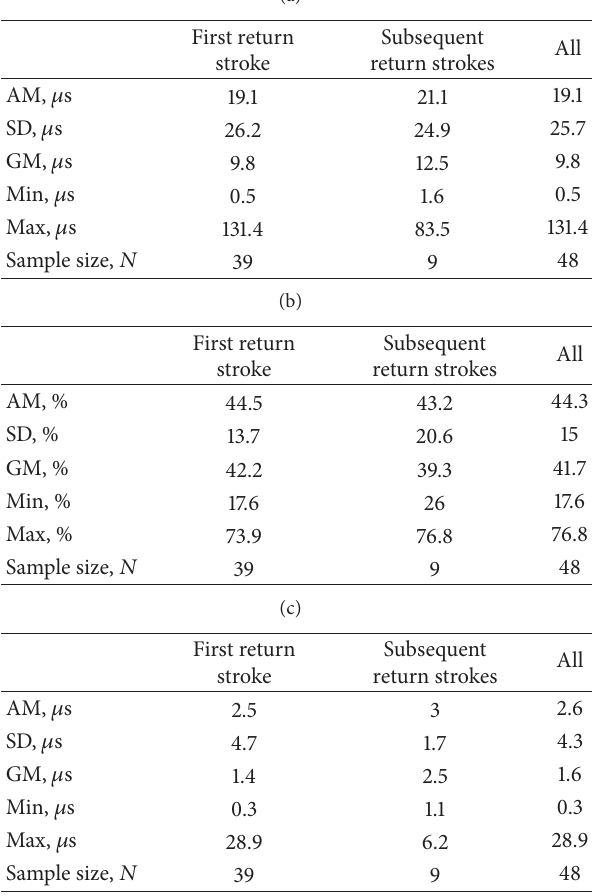
Table 4: Statistics for (a) slow front duration, (b) slow front ampli- tude relative to peak, and (c) fast transition rise time (10–90%).